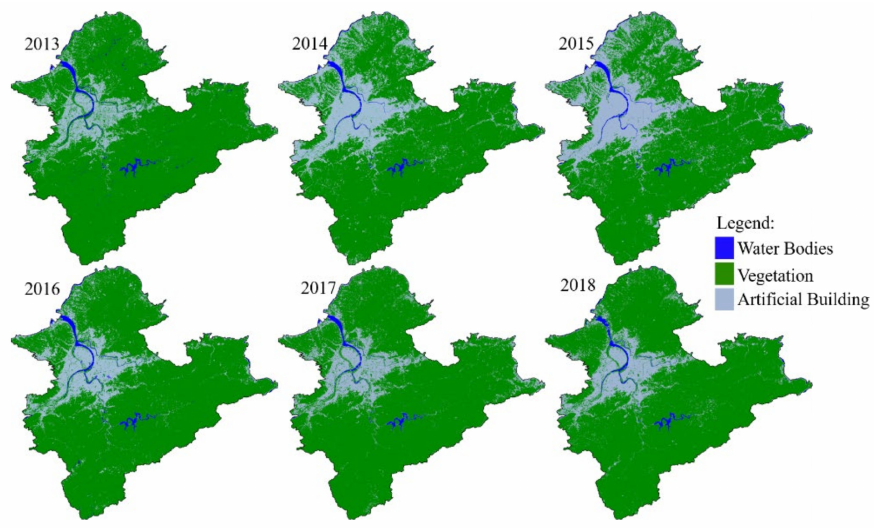
Figure 6. Land coverage information from satellite images using maximum likelihood